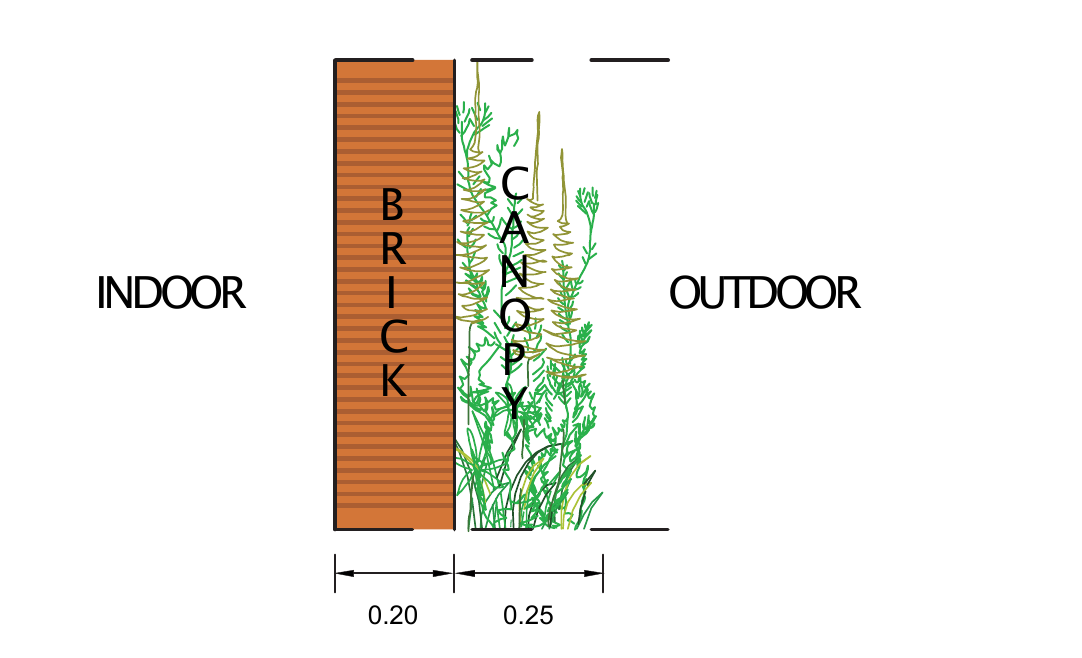
Figure 1. Two-layer greenery system (canopy-brick wall